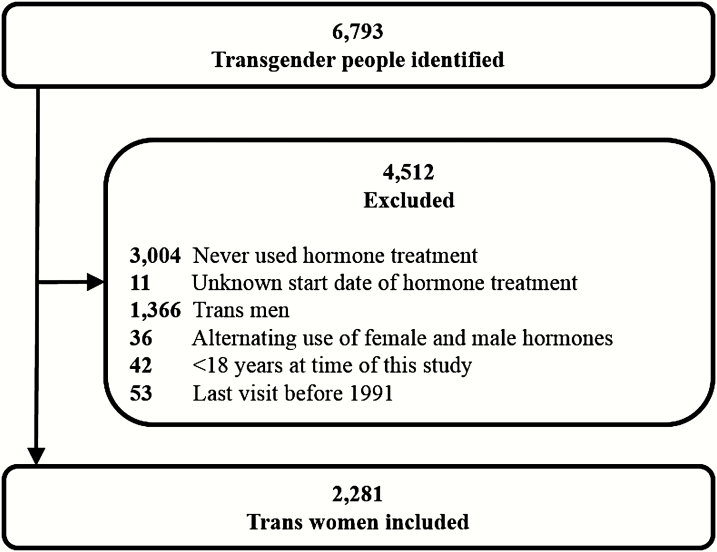
Study flowchart.